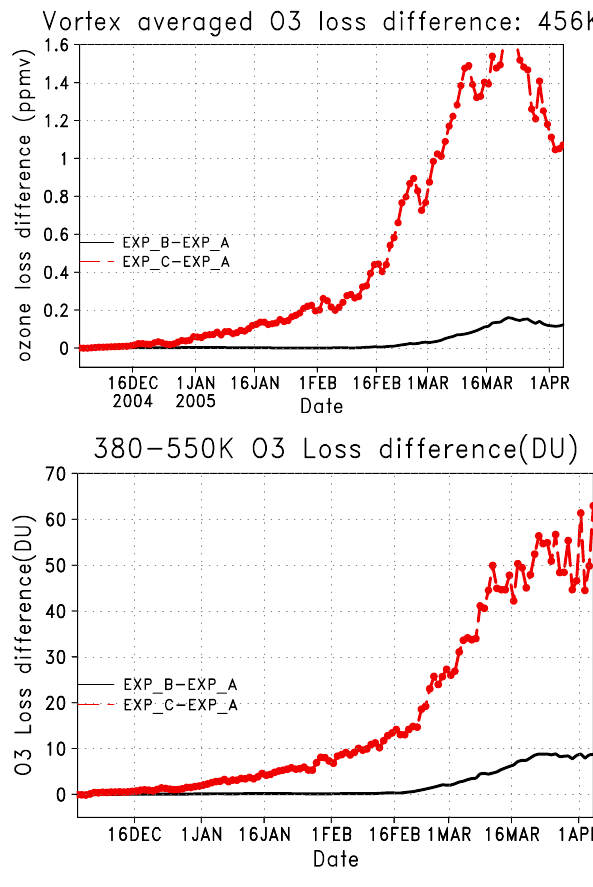
Fig. 8. Time series of differences in (a) vortex-averaged ozone loss ozone loss at 456K ( ∼ 17km) and (b) partial column ozone loss between 380–550K ( ∼ 13–23km) between model sensitivity experiments (EXP B, EXP C) and standard SLIMCAT simulation (EXP A) for Arctic winter